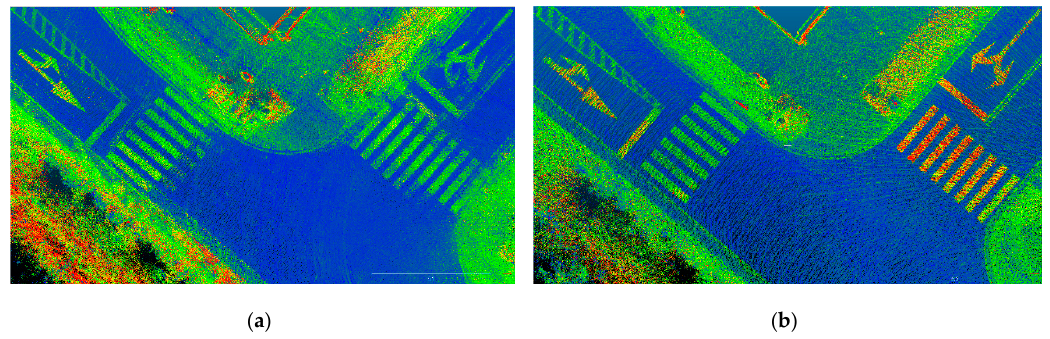
Figure 15. Top views of intensity point cloud showing ( a ) multi-scan dispersion effect due to GNSS/IMU trajectory error; ( b ) multi-scan dispersion issue is solved by NDT trajectory refinement.